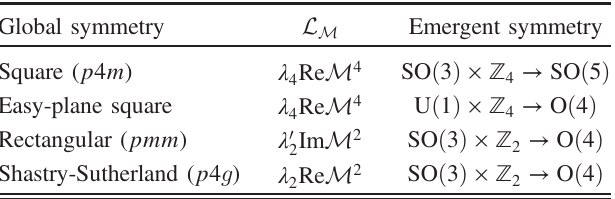
TABLE IV. Symmetry-allowed most-relevant monopole terms (apart from r M † M ) and the corresponding DQCP emergent symmetries on different lattices.